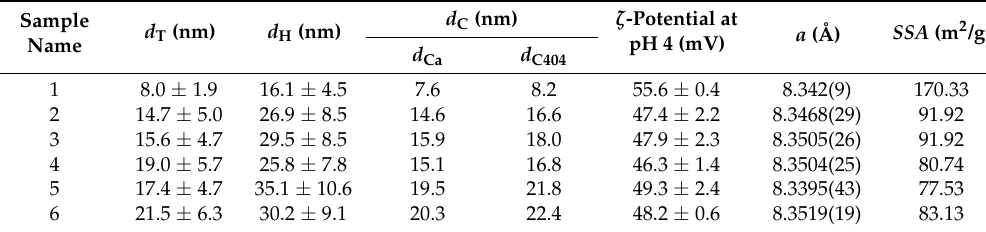
Table 1. Equivalent particle size or TEM diameter ( d T ), hydrodynamic diameter ( d H ) in water from number-weighted distribution, crystalline diameter ( d C ) (the average ( d Ca ) and obtained from the narrowest line (404) ( d C404 )), lattice parameter ( a ), ζ -potential at pH 4 and specific surface area ( SSA ) (measured by BET) of IONPs. Data are given as mean ± standard deviation. Standard deviation for d C and SSA is